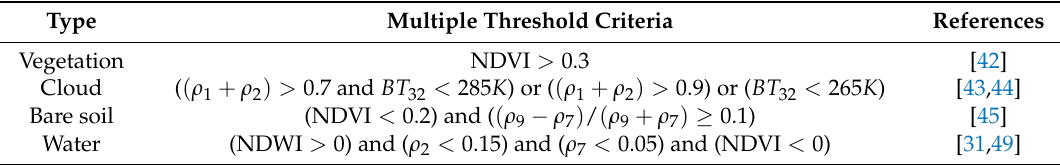
Table 3. Multiple threshold criteria used to extract samples of unburned types and water